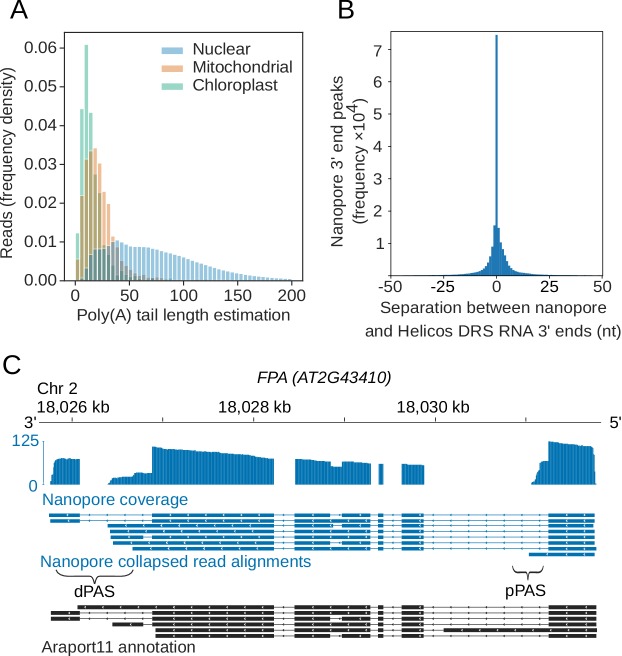
Nanopore DRS reveals poly(A) tail length and maps 3′ cleavage and polyadenylation sites.(A) Normalized histogram showing poly(A) tail length of RNAs encoded by different genomes in Arabidopsis. Blue, nuclear (n = 2,348,869 reads); orange, mitochondrial (n = 2,490 reads); green, chloroplast (n = 1,848 reads). (B) Distance between the RNA 3′ end positions in nanopore DRS read alignments and the nearest polyadenylation sites identified by Helicos data. (C) Nanopore DRS identified 3′ polyadenylation sites in RNAs transcribed from FPA (AT2G43410). Blue track, coverage of nanopore DRS read alignments; blue, collapsed read alignments representing putative transcript annotations detected by nanopore DRS; black, Araport11 annotation; pPAS, proximal polyadenylation site; dPAS, distal polyadenylation sites.Figure 2—source data 1.Poly(A) tail length estimations generated from Col-0 reads – Figure 2A.